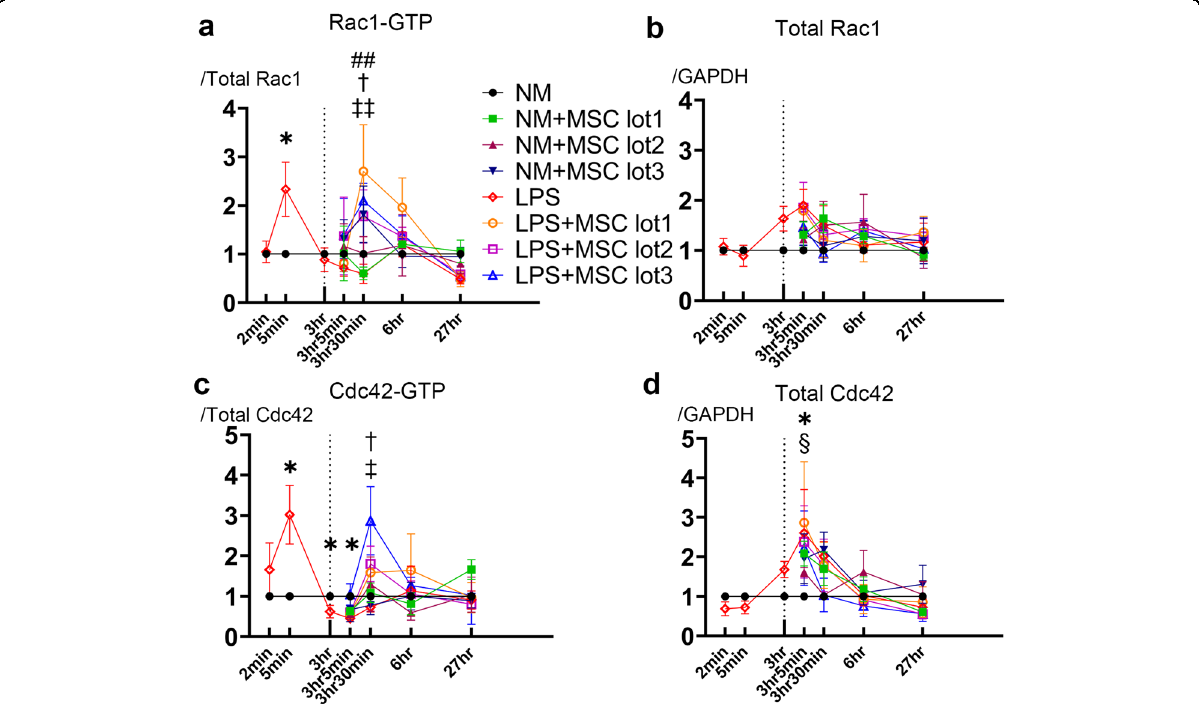
Fig. 5 Co-culture with MSC enhance the activation and expression of Rho GTPase in LPS activated microglia. Western blotting images of Rho GTPase, Rac1 and Cdc42 in 2 min, 5 min, and 3 h after LPS stimulation and 5 min, 30 min, 3 h and 24 h after MSC co-culture. The data represent at least three individual experiments ( a ). Quanti fi cation of Western blotting showed by time course. * p < 0.05; LPS group compared to NM group. § p < 0.05; NM + MSC lot1 group compared to the NM group. ## p < 0.01; LPS + MSC lot1 group compared to the LPS group. † p < 0.05; LPS + MSC lot2 group compared to the LPS group. ‡‡ p < 0.01, ‡ p < 0.05; LPS + MSC lot3 group compared to the LPS group. The expression level of Rac1-GTP and Cdc42-GTP were calculated by normalization to total Rac1 and total Cdc42, and the expression level of total Rac1 and total Cdc42 were calculated by normalization to GAPDH. (Mann – Whitney U-test and Dunn ’ s multiple comparisons test were used) ( b – e